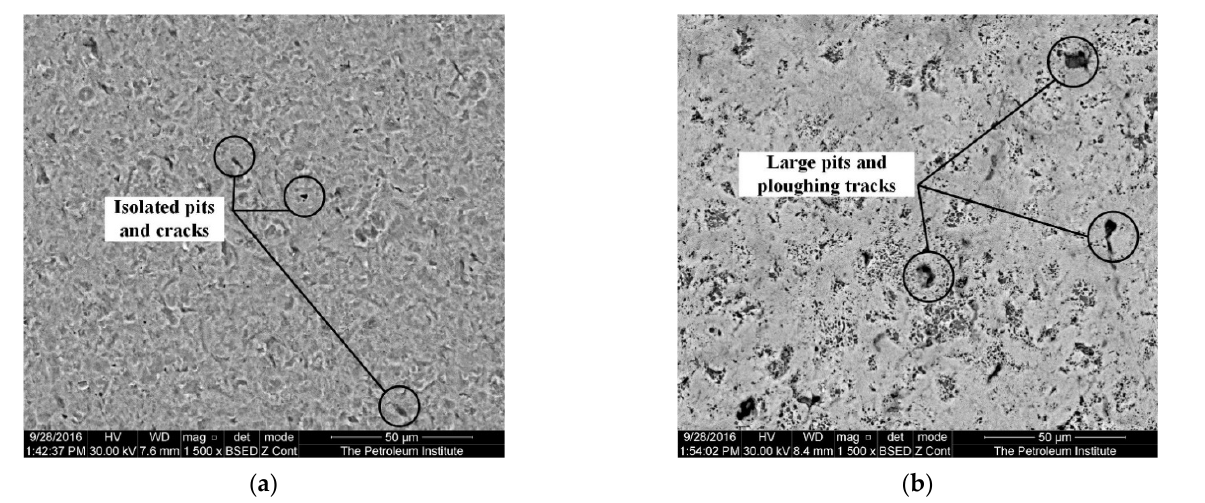
Figure 11. SEM of specimen after erosion–corrosion impingement test ( a ) at 10 m/s and 600 mg/L; and ( b ) at 20 m/s and 300 mg/L. and ( b ) at 20 m/s and 300 mg/L.